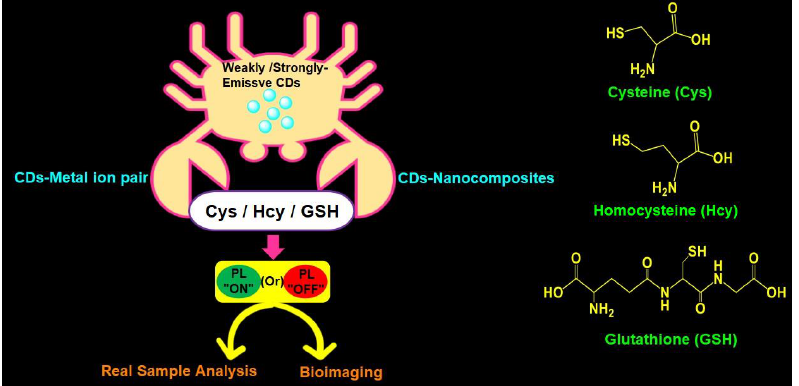
Figure 1. Schematic of fluorescent CDs-based assay of Cys, Hcy, and GSH with applications and structures of Cys, Hcy, and GSH.